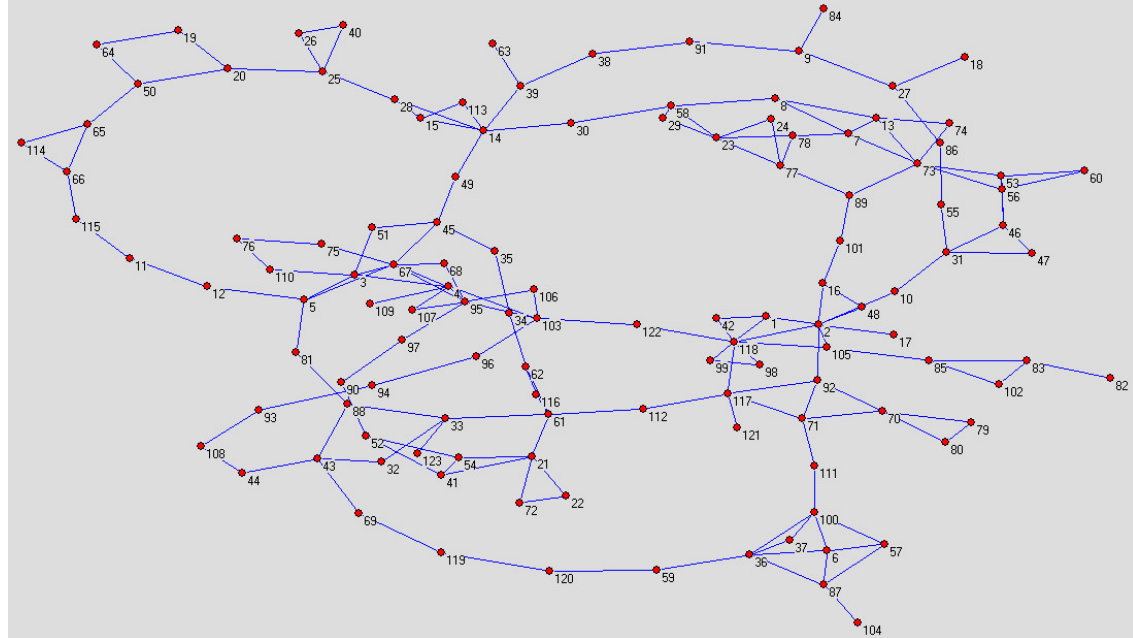
Figure 2: An example of a complex network corresponding to eye-tracking